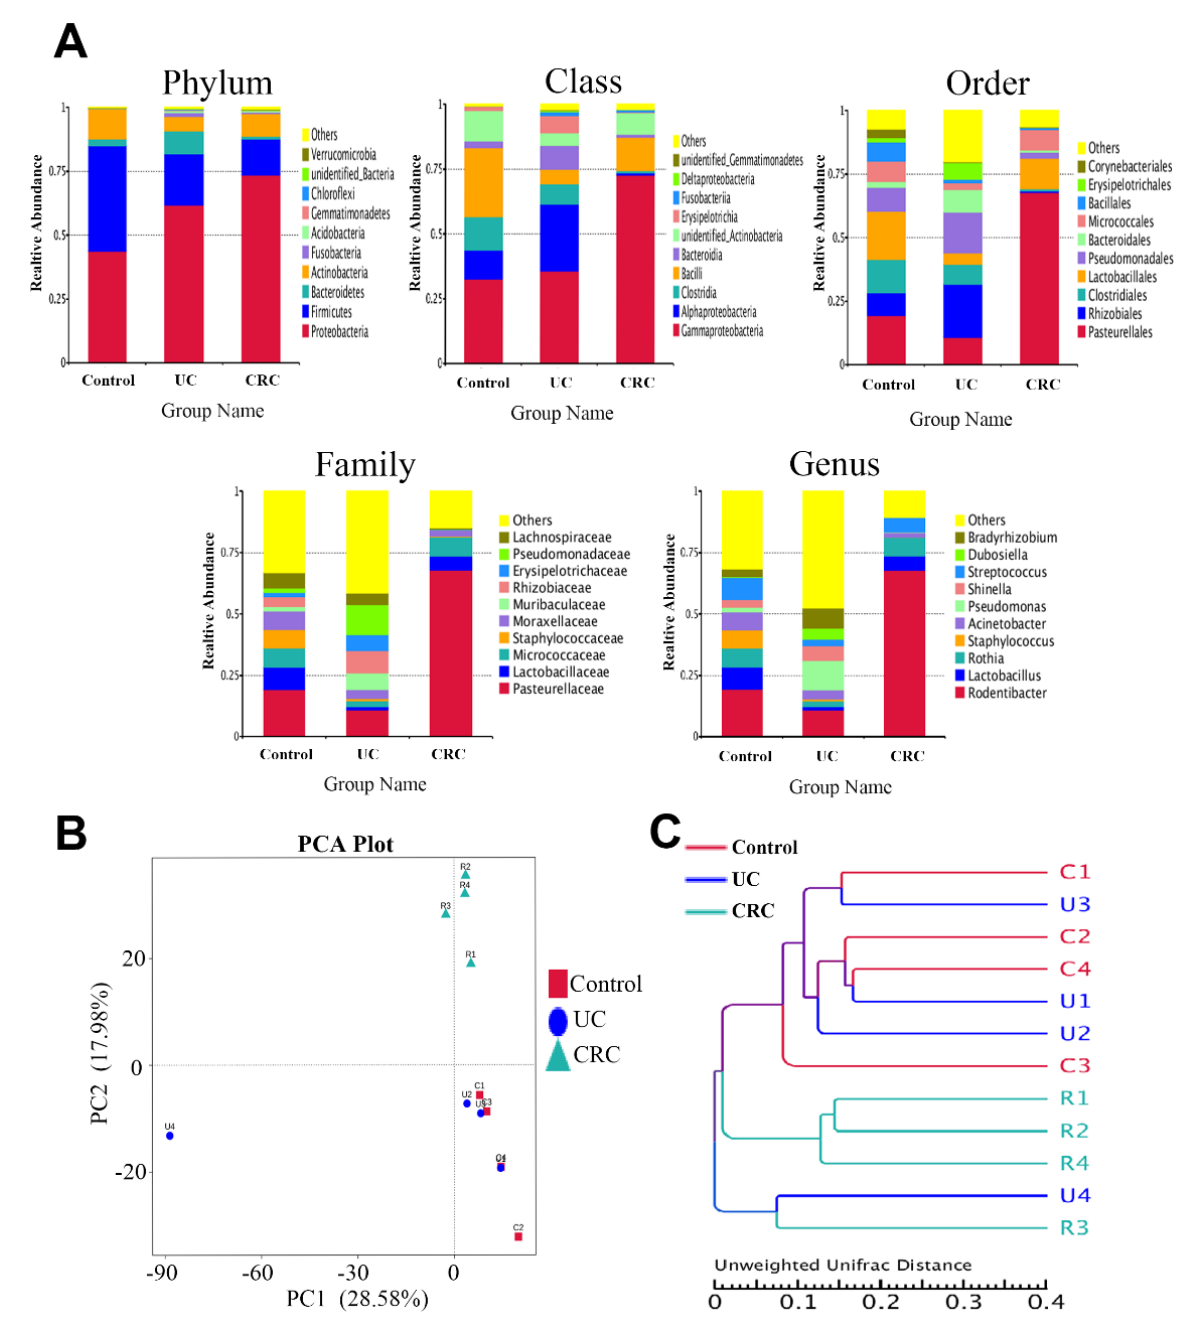
Figure 3. ( A ) Relative abundance of pulmonary microbiota at the phylum, class, order, family, and genus levels in the control, UC, and CRC groups. ( B ) PCA analysis diagram. ( C ) Sample UPGMA cluster tree.